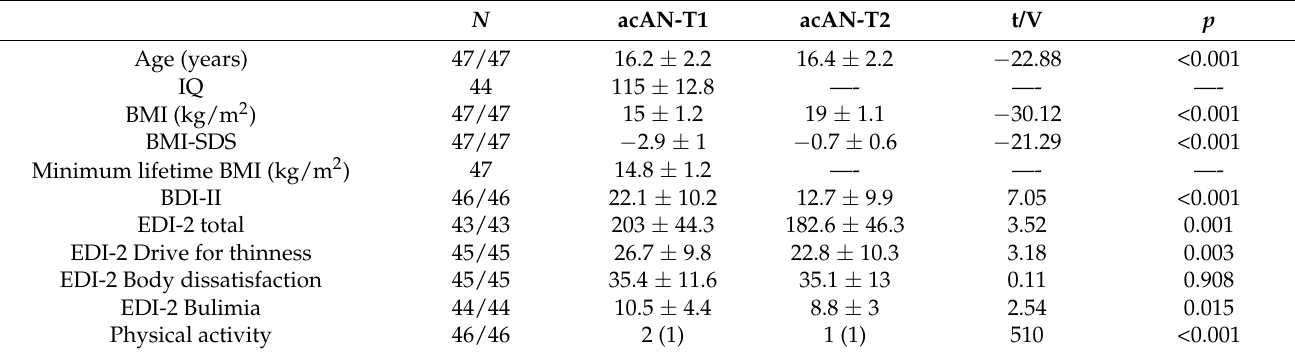
Table 2. Longitudinal study sample: demographic and clinical